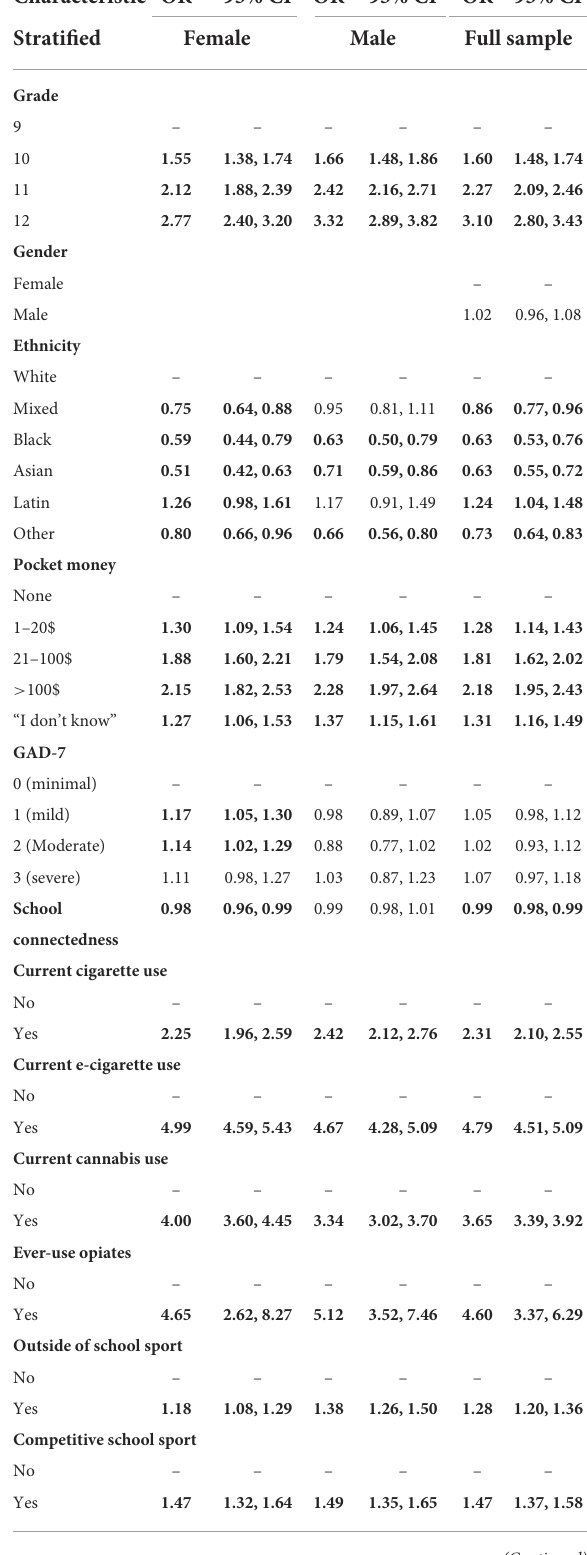
TABLE 5 Full model summaries for current binge